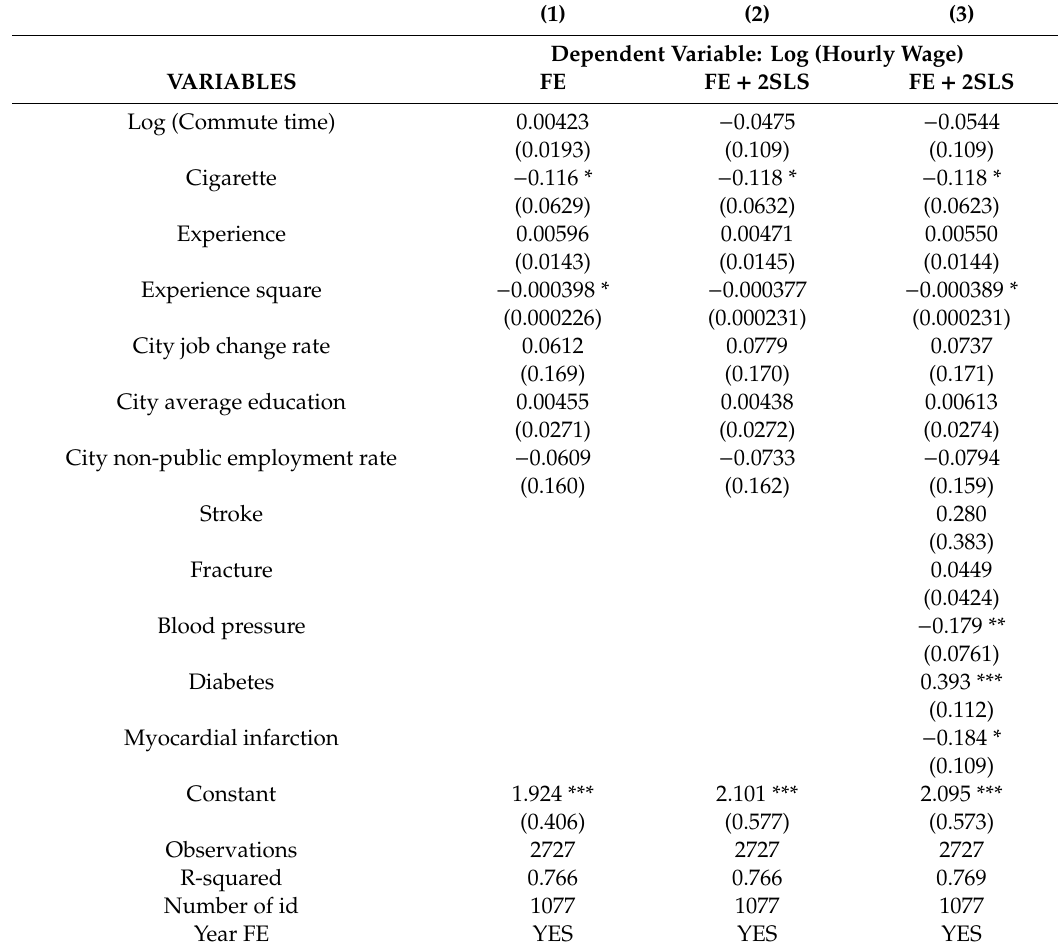
Table 3. Hourly wage regression